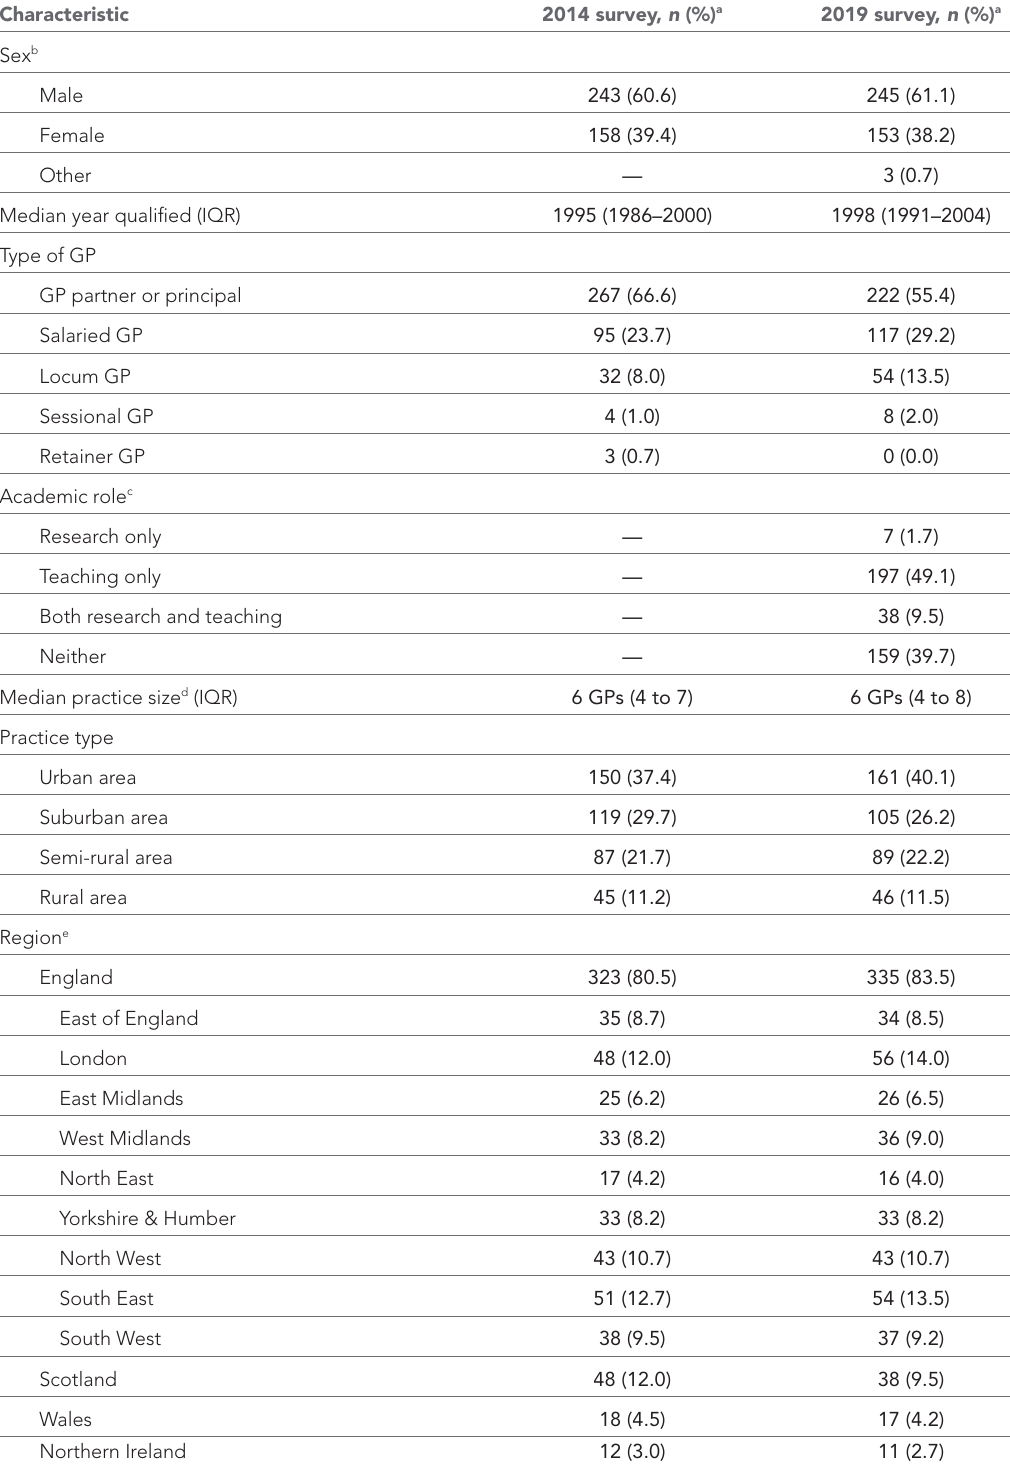
Table 2 Characteristics of GPs and their practices, N = 401